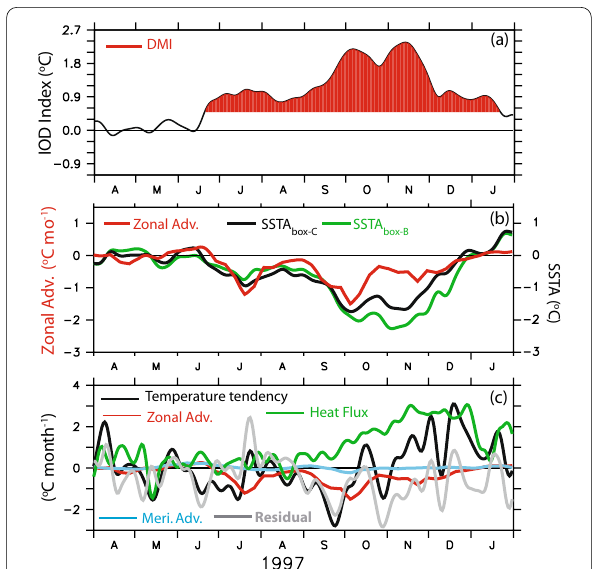
Fig. 2 a DMI for a period of June 1997–March 1998. Values above one standard deviation are highlighted in red ( b ). Time series of SSTA in the box-B (green) and in the box-C (black), time series of the zonal heat advection (red). c Time series of mixed layer heat budget components, including temperature tendency (black), net surface heat flux (green), zonal heat advection (black) and meridional heat advection, which is barely discernable ( blue) and the residual term (gray)